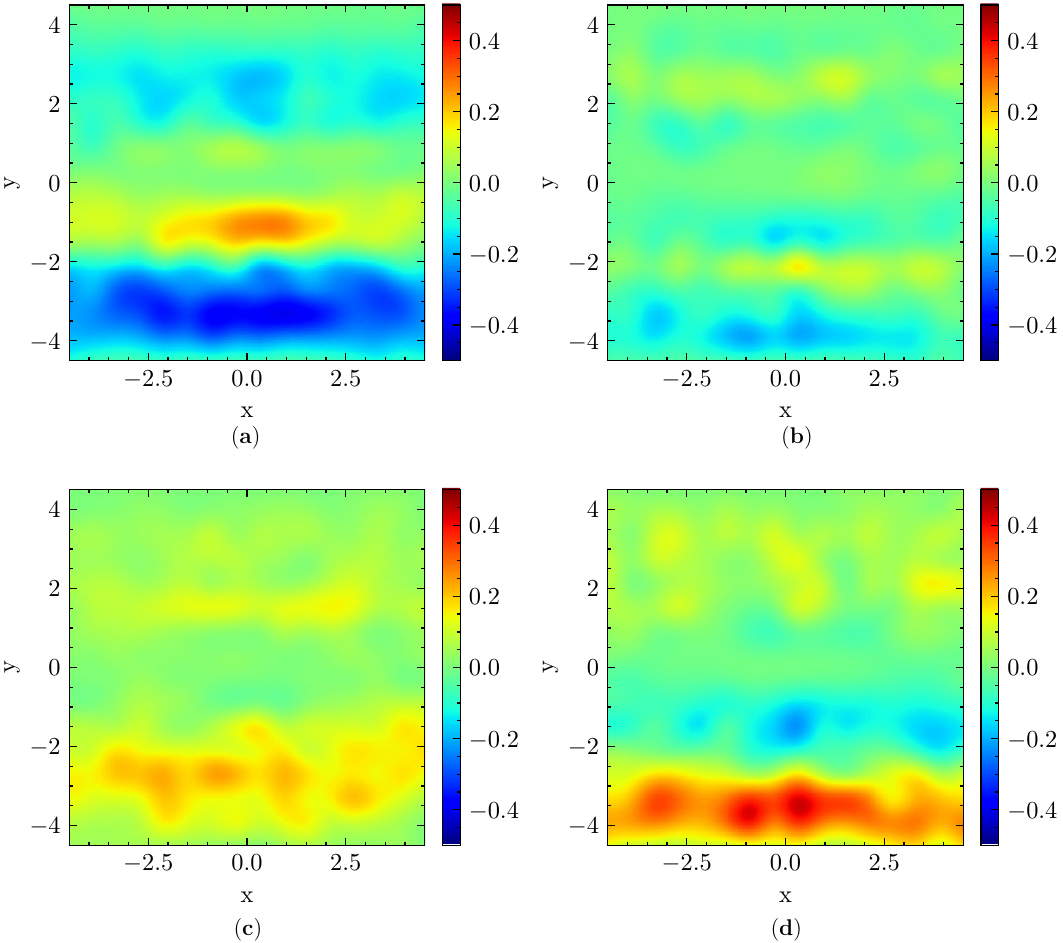
Figure 4. 2D distribution of individuals’ position ¯ r relative to overall average. Positions are shown in the group- centered reference frame and the x axis is aligned with the direction of motion of the group. Each sub-figure depicts the difference between the distribution relating to a certain intensity of interaction and an unweighted average of all intensities. ( a ) 0, ( b ) 1, ( c ) 2, ( d ) 3. The color scales are adjusted for highlighting the